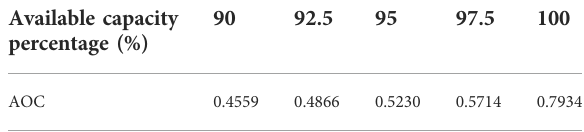
TABLE 5 AOC of wind power corresponding to key AOC in